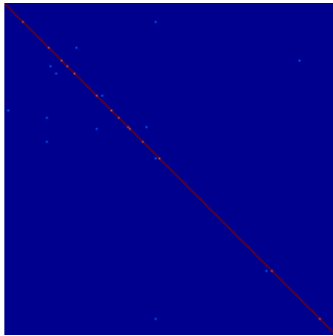
Figure 5. A heat map representation of the confusion matrix of the recognition evaluation. It goes from dark blue to dark red, where the representations of higher values are close to dark red.